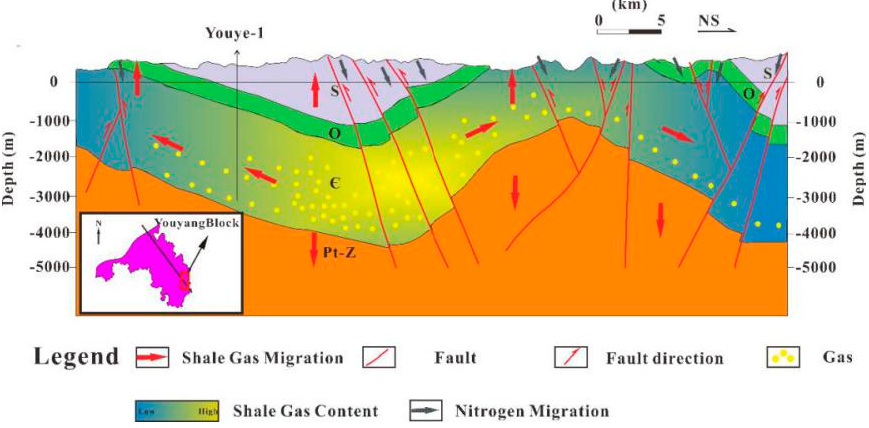
Figure 7. Seismic interpretation results for Southeast Chongqing region.